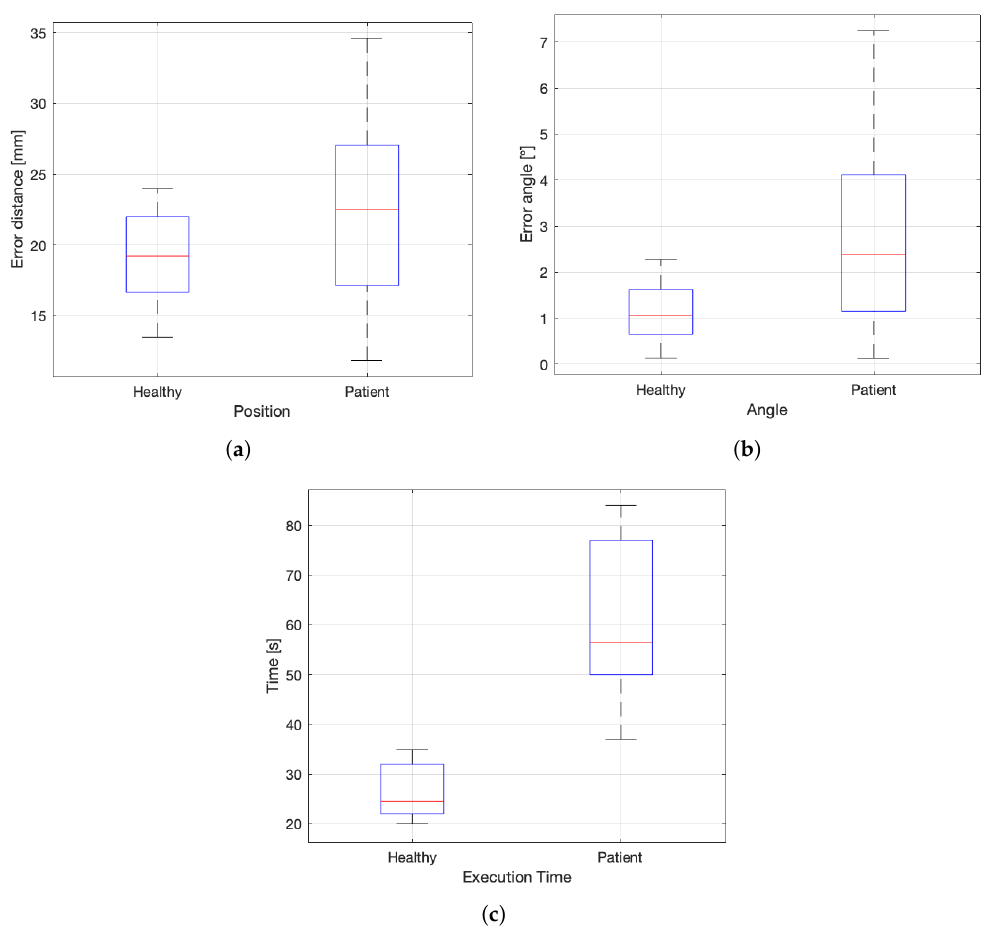
Figure 15. Boxcharts of the median error in ( a ) position ( p -value = 0.001), ( b ) angle ( p -value = 2.4 × 10 − 7 ) and ( c ) execution time ( p -value = 4.8 × 10 − 5